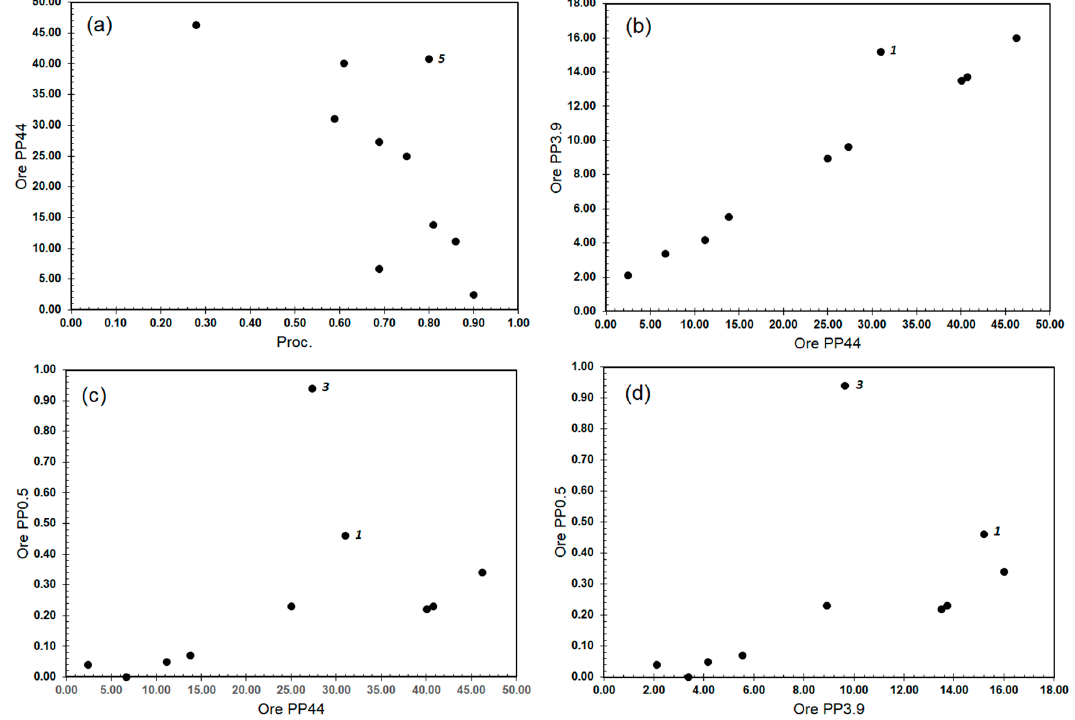
Figure 6. Scatterplots of ore processability (Proc.) and %fines (pp44 and pp3.9) and ultrafines (pp0.5) characteristics of ore. ( a ) pp44% versus processability. ( b ) pp3.9% versus pp44%. ( c ) pp0.5% versus pp44%. ( d ) pp0.5% versus pp3.9%. Numbers refer to the sample ID listed in Table 1.